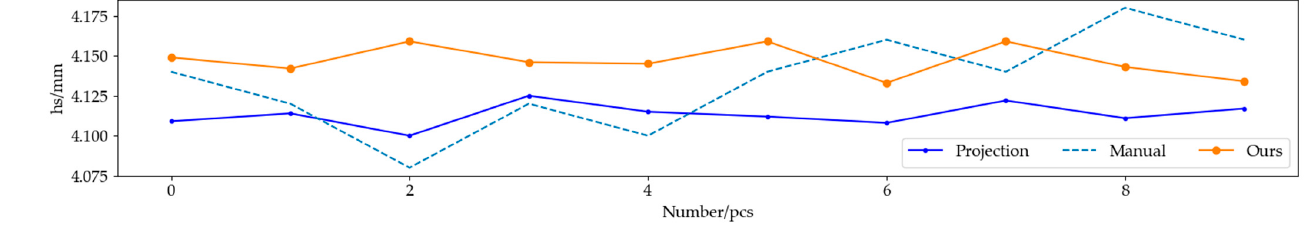
Figure 15. Graph of hs measurement data.